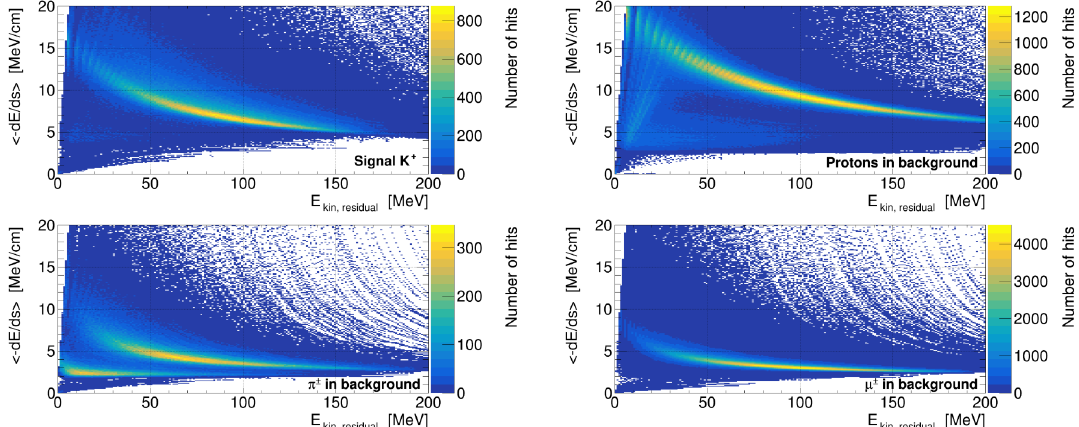
Figure 6 . Track stopping power profiles with the mean stopping power h− dE/ds i and residual kinetic energy E kin, residual at each hit for K + in the reference signal sample (top left) and for protons (top right), pions (bottom left) and muons (bottom right) in the reference 10 megaton · years background sample after event and particle preselection. In-flight decaying pions cause a secondary band at low stopping powers and residual kinetic energies without Bragg